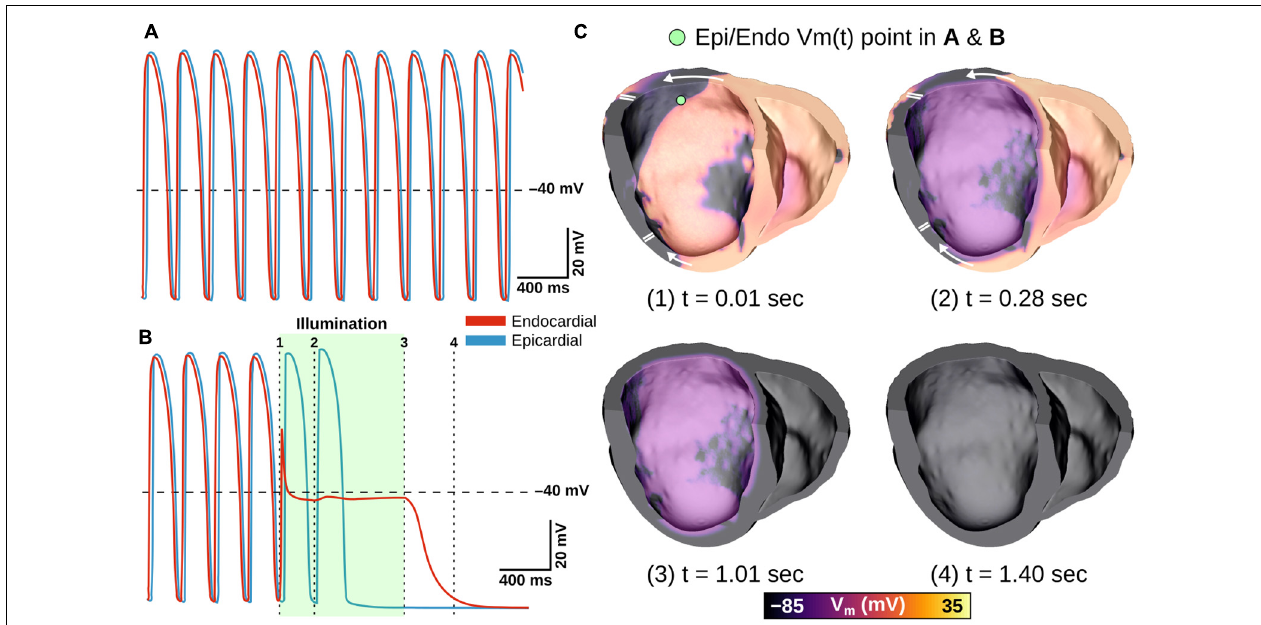
FIGURE 7 | Representative example of LV defibrillation attempt in GtACR1-expressing model V01 with E e = 0.5 mW/mm 2 . V m (t) traces from the LV endocardial surface are provided for the control case (A) and GtACR1-expressing model (B) . Green shaded region in (B) shows illumination interval. Cut plane V m (t) snapshots of the GtACR1 case (C) show conduction block affecting wavefront propagating circumferentially in LV free wall, followed by eventual arrhythmia termination. Arrows indicate wavefront propagation directions. Double lines show sites of conduction block.